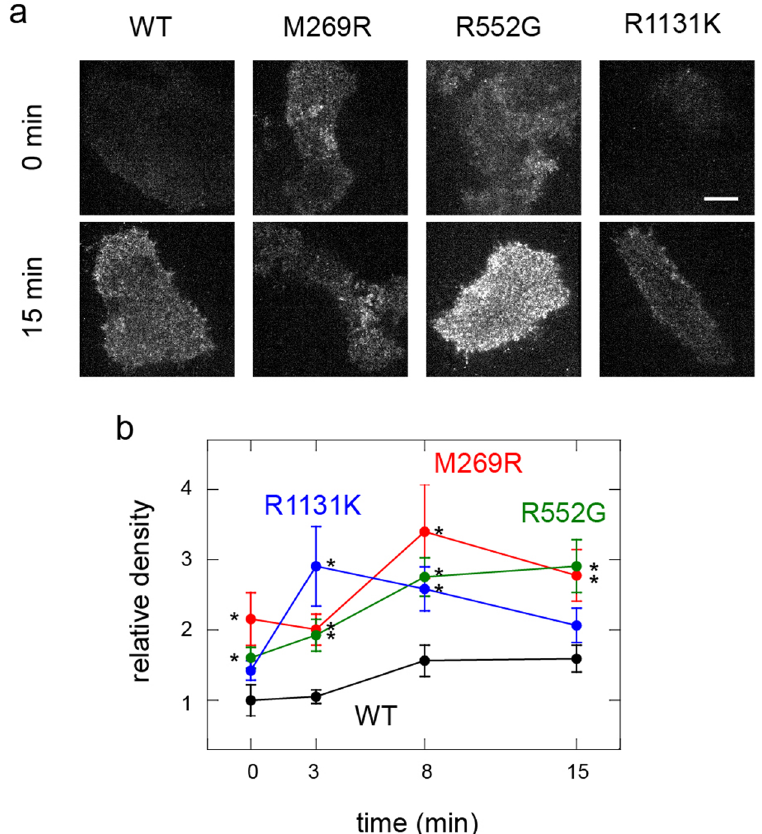
Figure 4. RAF translocation in cells expressing NS SOS mutants. ( a ) Typical micrographs show the cell-surface density of RAF molecules before (0 min) and after EGF stimulation for 15 min. Transfected cells expressed the indicated SOS molecules and GFP–RAF simultaneously. GFP–RAF on the basal cell surface was observed with a TIRF microscope. Bar: 20 μ m. ( b ) Time courses of RAF translocation in cells expressing SOS and GFP– RAF molecules. Densities of GFP–RAF molecules on the cell surfaces were normalized to the intensity in the cytoplasm. The values were further normalized to that of cells expressing WT SOS before EGF stimulation (time 0). Average of 7–12 cells with SE. Asterisks show statistical significance relative to the densities in WT at the indicated times (p < 0.05 on Mann–Whitney